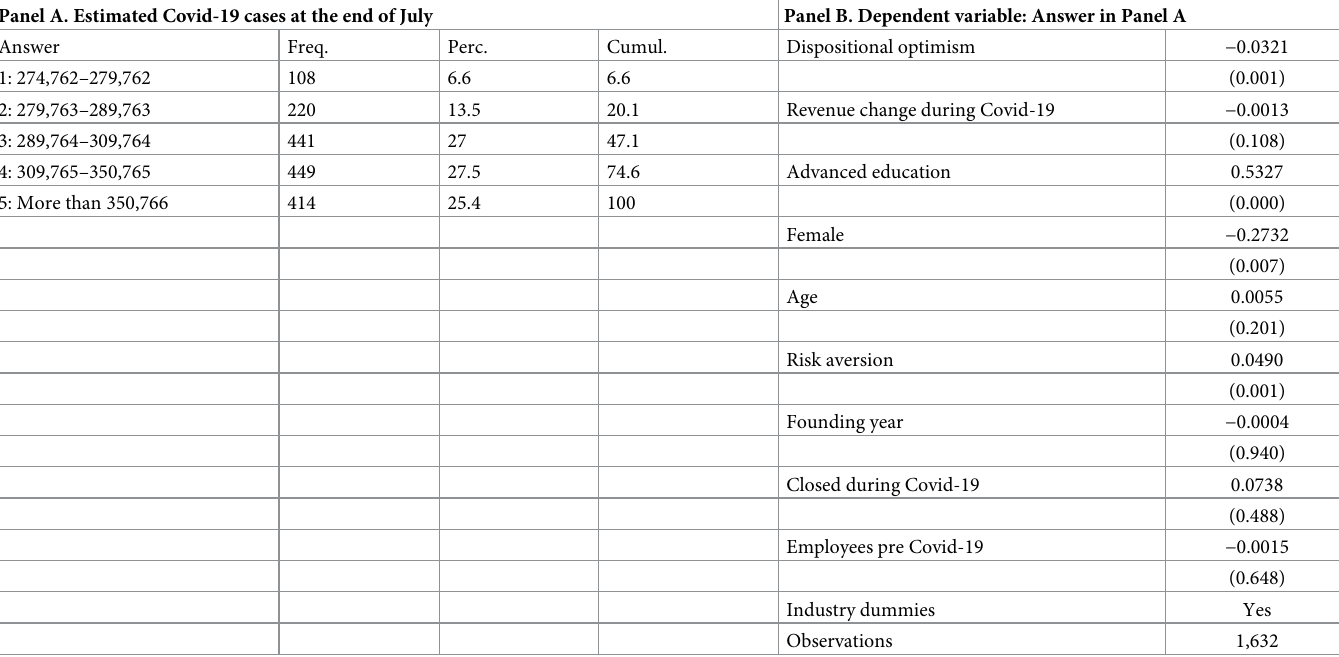
Table 5. Optimism and expectations about the diffusion of Covid-19. Panel A. Estimated Covid-19 cases at the end of July Answer Freq.